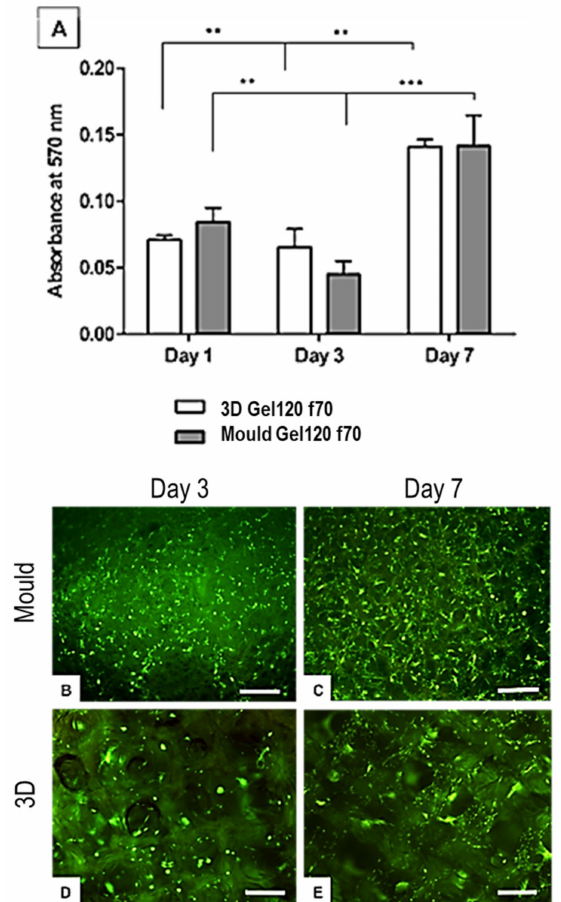
Figure 10. Cell viability analysis. MTT assay was performed after 1, 3, and 7 days of cell culture ( A ). The results were reported in the graph as mean ± standard error of the mean. ** p -value ≤ 0.01, *** p -value ≤ 0.001. Live&/Dead assay (Calcein stains live cells in green, ethidium homodimer-1 stains dead cells in red) on cells seeded on Gel120 f70 mould-casted ( B ) day 1; ( C ) day 3 and Gel120 f70 3D printed scaffolds ( D ) day 1, ( E ) day 3. Scale bars: 500 µ